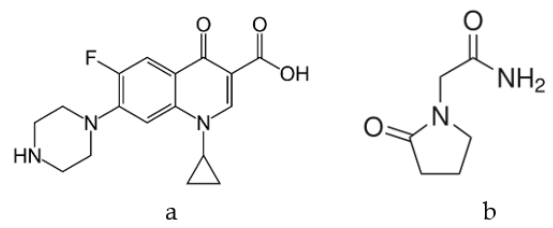
Figure 1. Ciprofloxacin ( a ) and piracetam ( b ) molecules.